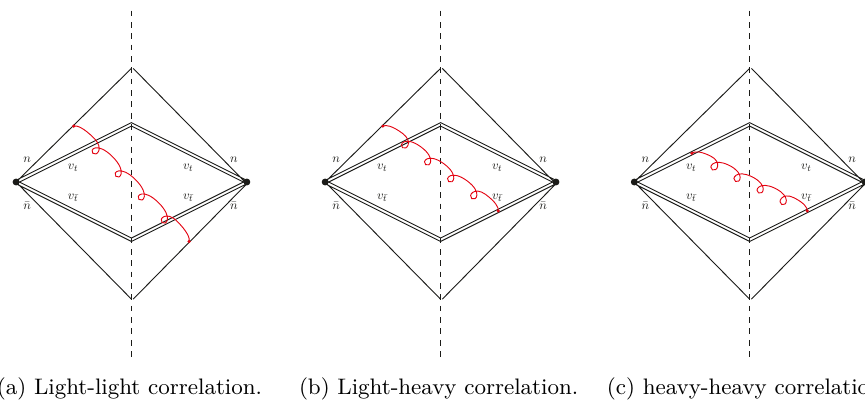
Figure 4 . Representative Feynman diagrams for the NLO soft function. The double line represents the gauge links attached to the top or antitop quark. The single line stands for that from the incoming massless parton, such as gluon, quark, and